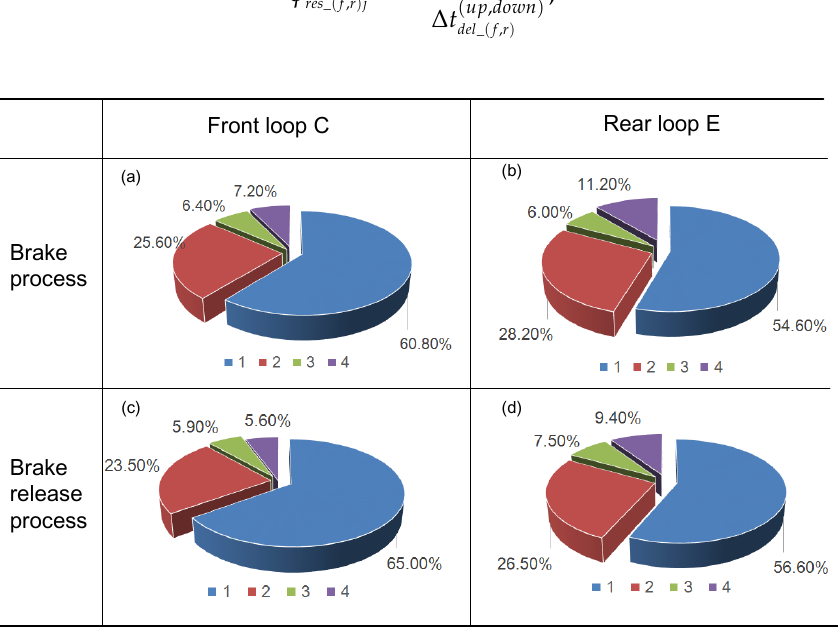
Figure 17. Average proportion of response time of each subassembly under the testing condition from group 1 to group 5. ( a ) Subassemblies in front loop C in brake process; ( b ) Subassemblies in rear loop E in brake process ; ( c ) Subassemblies in front loop C in brake release process; ( d ) Subassemblies in rear loop E in brake release process; (1—treadle valve; 2—controlling pipeline; 3—relay valve; 4—braking pipeline).